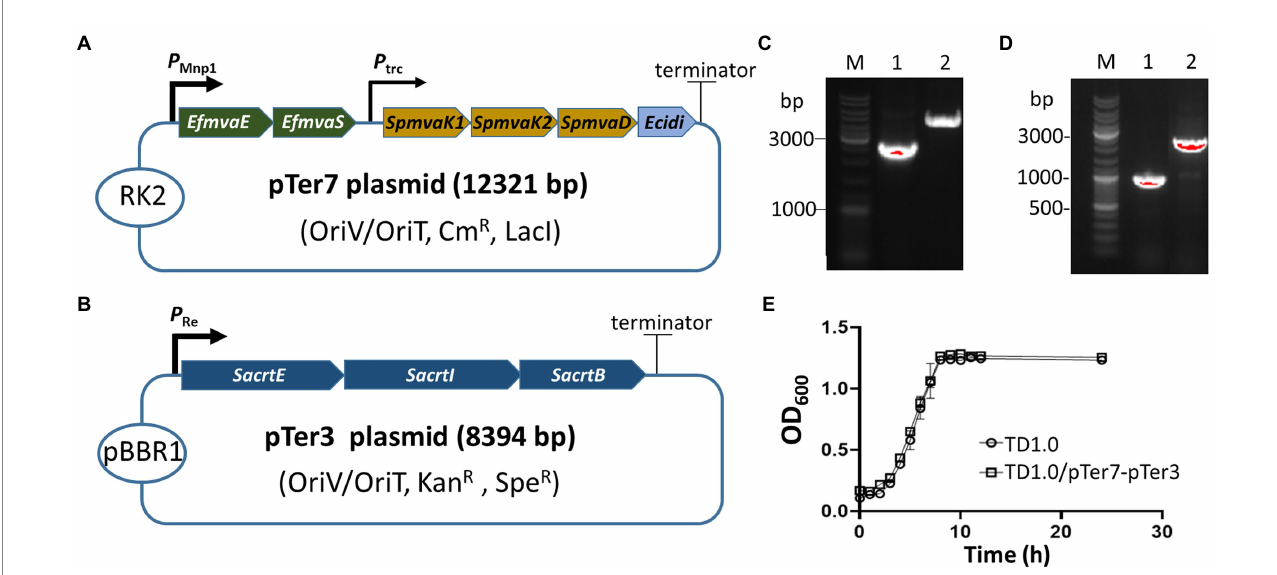
FIGURE 1 Construction and identification of the lycopene-producing Halomonas bluephagenesis strain TD1.0/pTer7-pTer3. (A) Schematic diagram of the construction of the pTer7 plasmid carrying genes involved in the MVA pathway. (B) Diagram representing the construction of pTer3 harboring SacrtE , SacrtI , and SacrtB genes. (C) PCR characterization of pTer7 and pTer3 plasmids in diverse Escherichia coli S17-1 strains. Lane 1, PCR products using jxr53-6/ pMVA112 primers from the pTer7 template (approximately 2.6 kb). Lane 2, PCR products using F24/R24 primers from the pTer3 template (about 4.4 kb). The represented molecular size of the DNA Marker was indicated on the left. (D) PCR analysis of pTer7 and pTer3 plasmids in H. bluephagenesis strain TD1.0/ pTer7-pTer3. Lane 1, PCR products using 24R/jxr53-6 primers from the pTer7 template (1.0 kb). Lane 2, PCR products using jxr53-5/jxr53-6 primers from the pTer3 template (2.0 kb). All primers used were listed in Supplementary Table 2. (E) The growth curves of H. bluephagenesis strains TD1.0 wild-type and